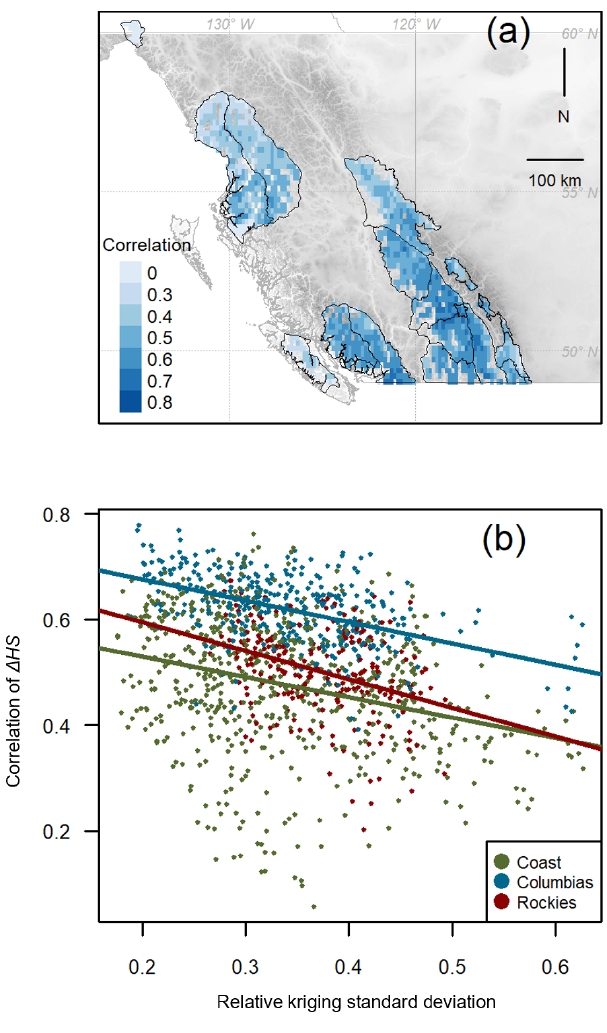
Figure 7. Correlation between daily change in snow depth (cid:49) HS from model and upscaled observation data over the study period (a) mapped across the study area and (b) plotted against the average relative kriging standard deviation representing the uncertainty in the upscaled observations. Simple regression lines are fitted for each mountain range to show poorer (cid:49) HS correlations when upscaled observations had greater uncertainty.